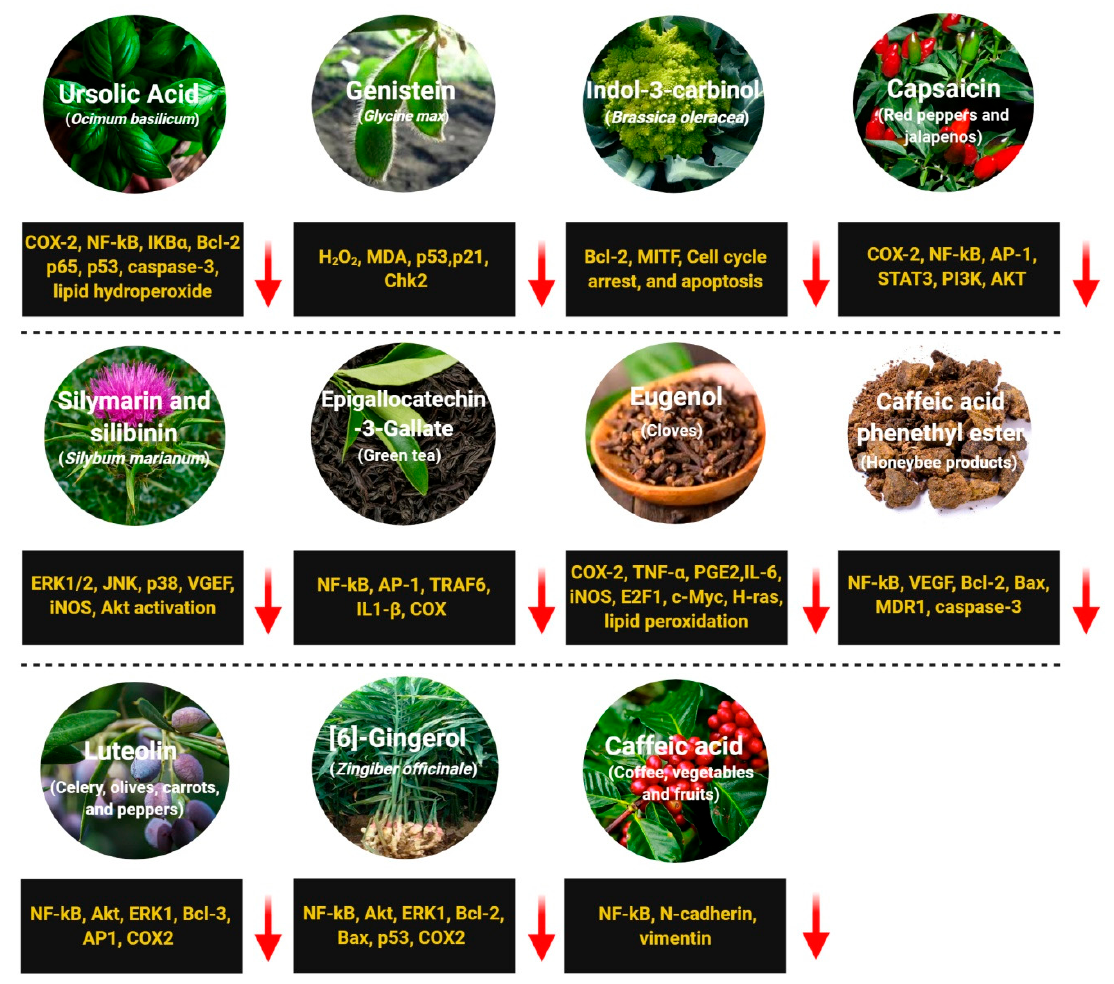
Figure 4. Regulation of various proteins, enzymes, and cellular signaling pathways by dietary phytochemicals in the prevention of skin cancer. Red down arrows indicate downregulation.